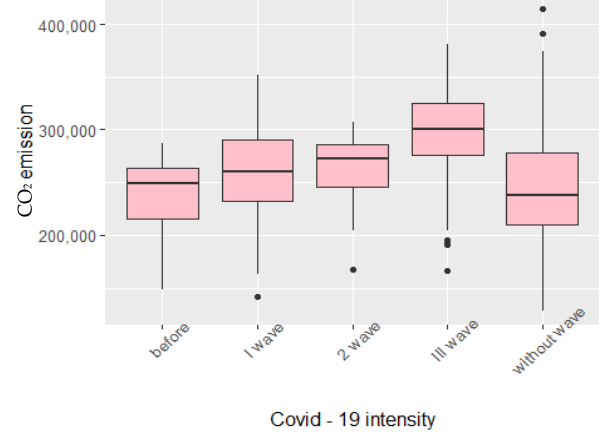
Figure 4. Box plot of CO 2 emissions in each pandemic wave.